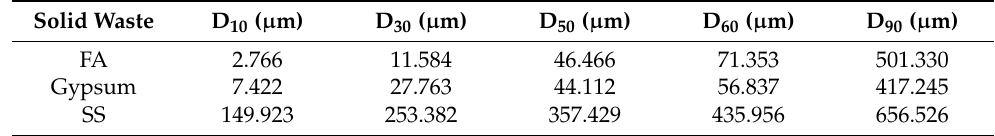
Figure 1. The solid waste particle size distribution. Table 1. Physical parameters of the tested solid